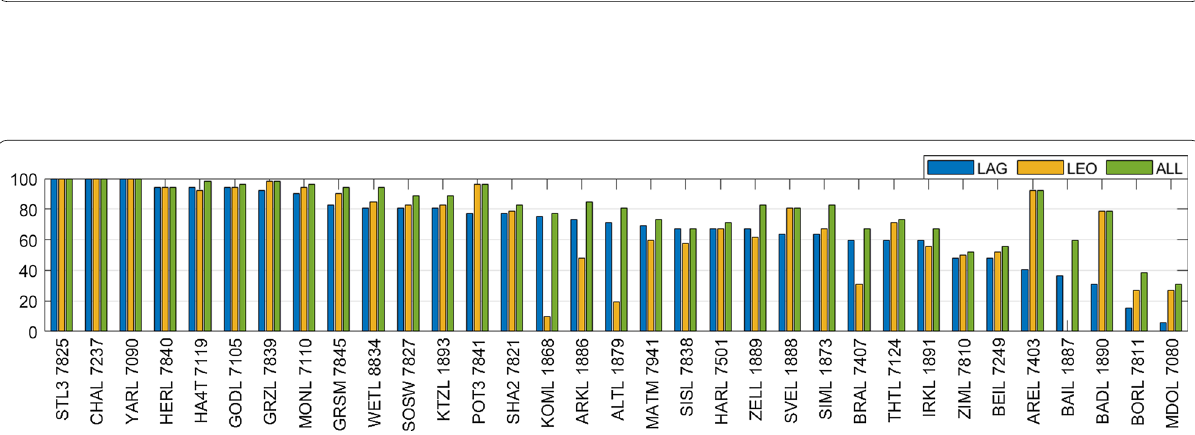
Fig. 9 The occurrence of SLR stations in 7-day solutions in the period 2016.0–2017.0 (expressed as percentage of possible to obtain 7-day station